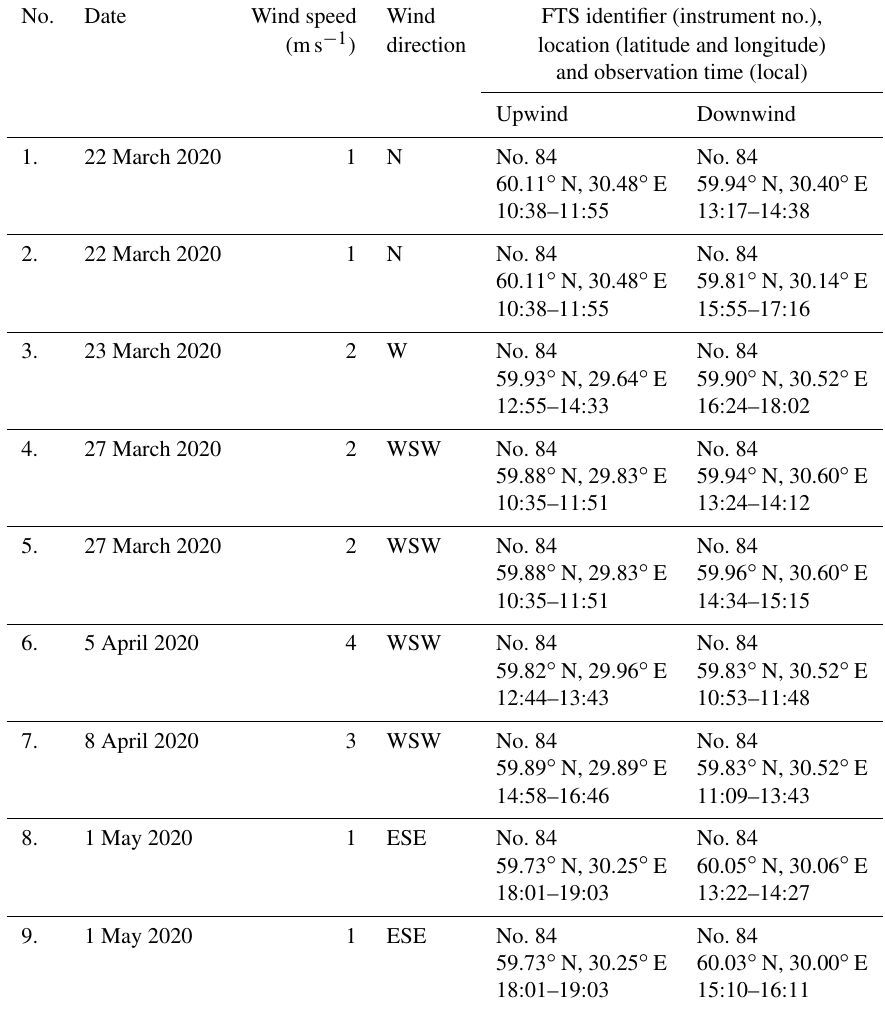
Table 2. The EMME-2020 field campaign details, including the dates of the experiments in 2020 and the locations of FTS instrument during the upwind and downwind observations. The data on the direction and speed of the surface wind correspond to observations at one of the meteorological stations in the centre of St Petersburg at local noon (http://rp5.ru/Weather_archive_in_Saint_Petersburg, last access: 11 March